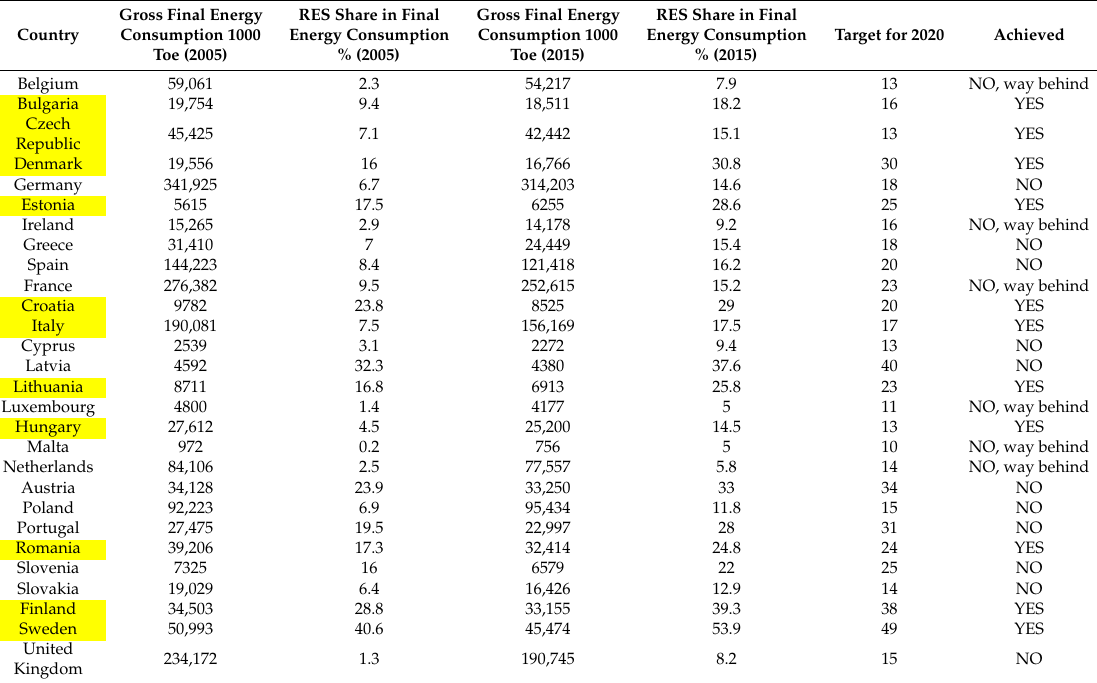
Table 2. Gross final energy consumption and shares of RES in gross final energy